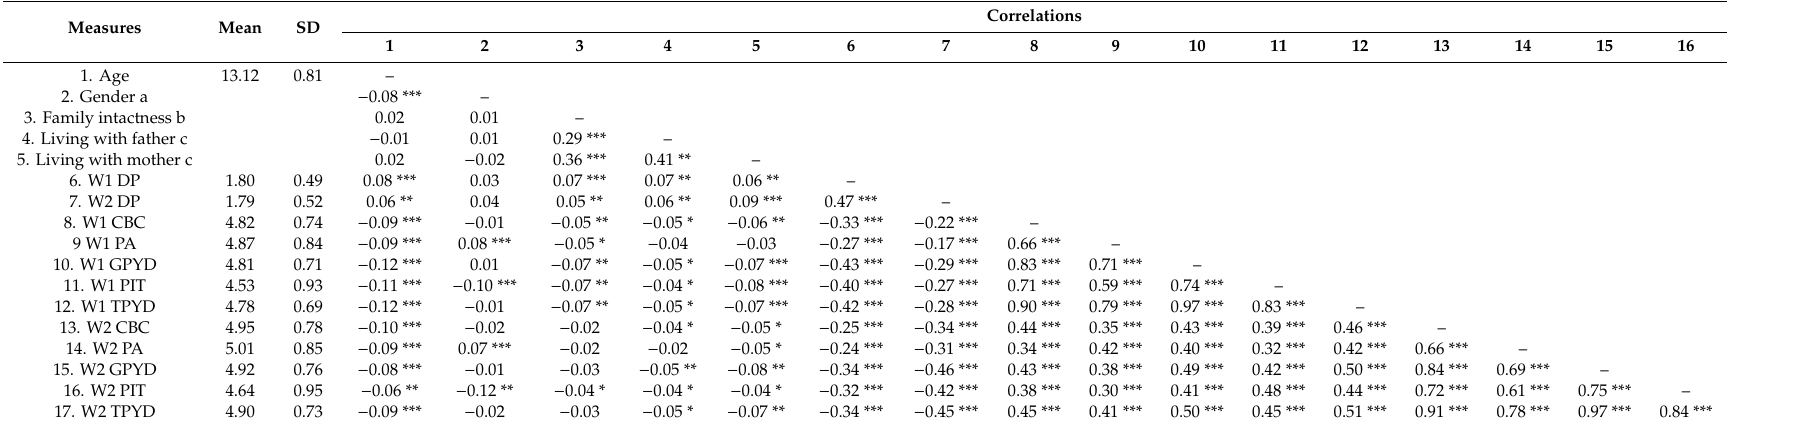
Table 2. Descriptive and correlational